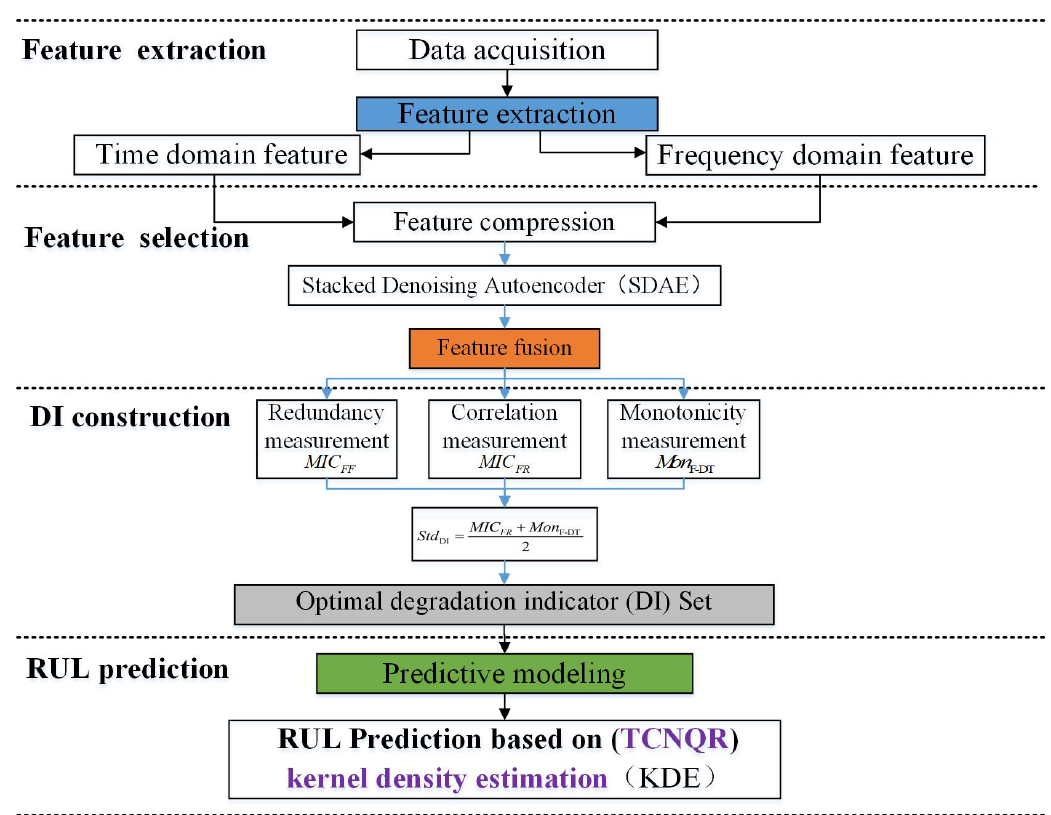
Figure 3. The structure of the bearings RUL prediction model